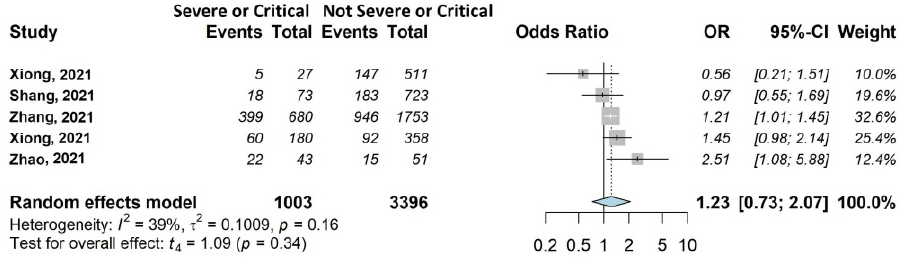
Figure 6. Forest plots of adjusted analyses for association between sex (female) and fatigue. HKSJ, Hartung-Knapp-Sidik-Jonkman.